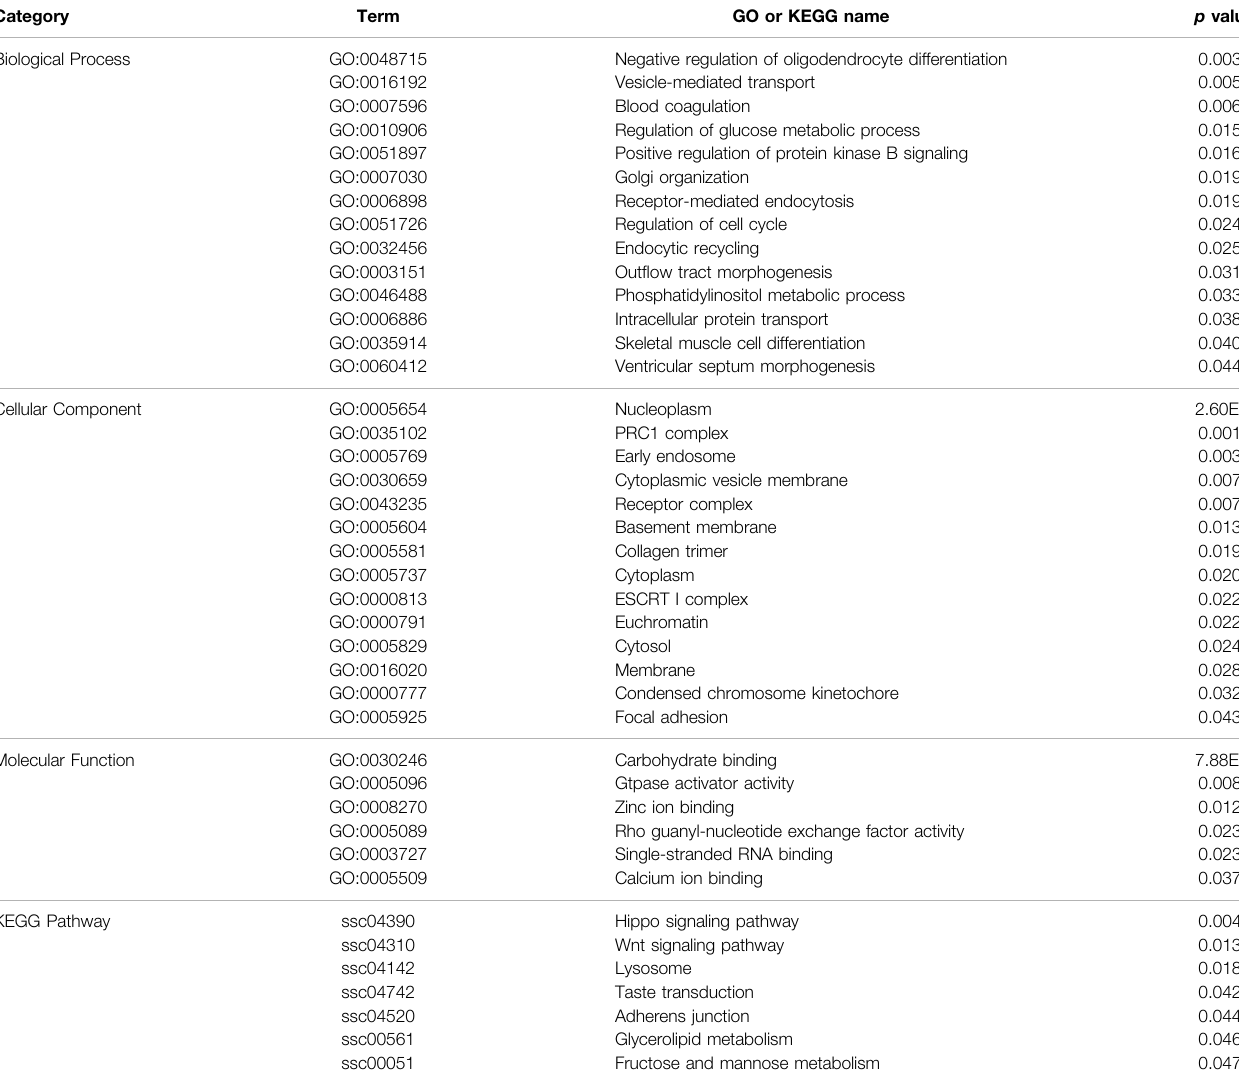
TABLE 2 | GO and KEGG pathway analyses of genes in the identi fi ed CNVRs.